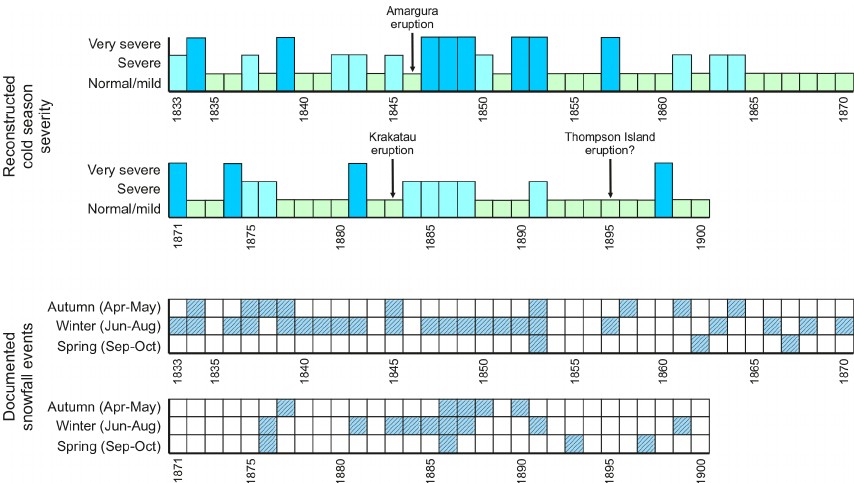
Figure 7. Three-point “cold season severity” index for Lesotho and surrounding areas during the 19th century (top), with major volcanic eruptions indicated. The occurrence of snowfall events (bottom) during the same period is also shown (modified after Grab and Nash, 2010).